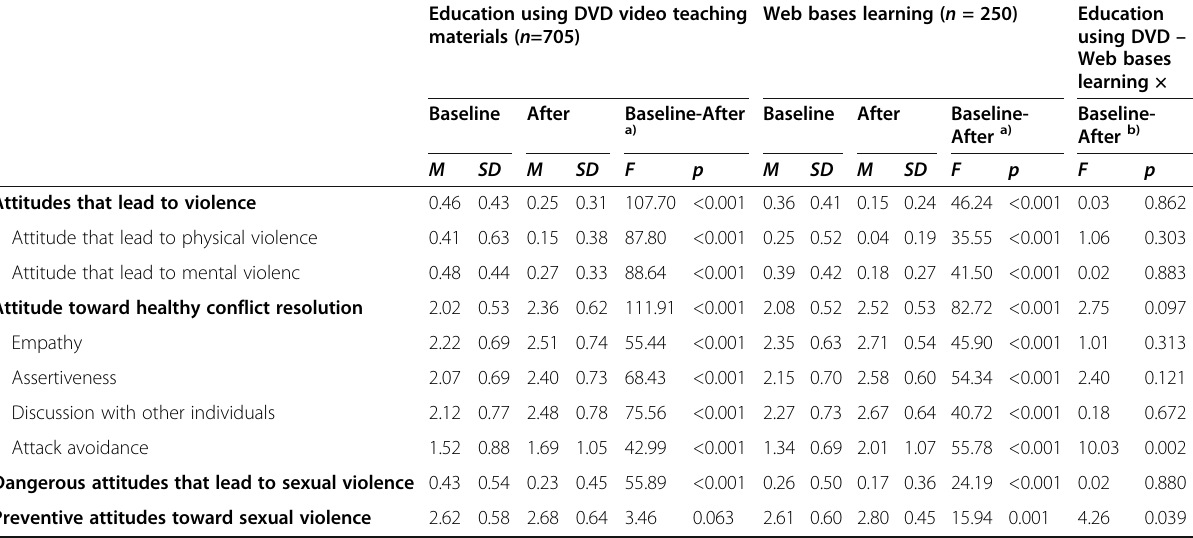
Table 2 Two-way ANOVA for the differences of the variables according to the interaction between baseline/after or education using DVD video teaching materials/the web-based learning program and each mean